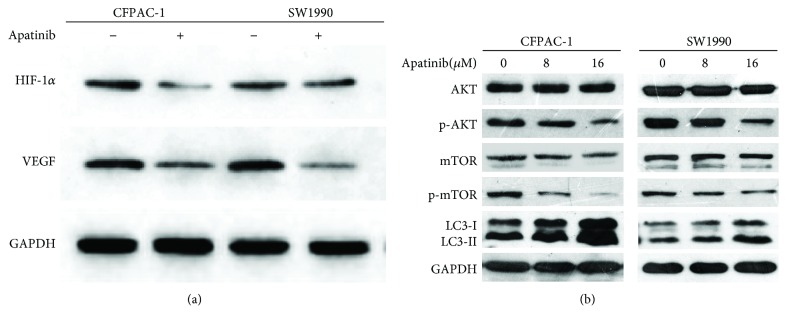
Apatinib inhibited the expression of HIF-1α and the AKT/mTOR pathway. (a) CFPAC-1 and SW1990 cells were treated with apatinib (0 or 16 μM) for 24 h, and alterations in the expression of HIF-1α and VEGF were determined through western blotting. GAPDH was included as a loading control. (b) CFPAC-1 and SW1990 cells were treated with different concentrations of apatinib (0, 8, and 16 μM) for 24 h, and the levels of phosphorylated AKT, mTOR, and LC3 were determined through western blotting. GAPDH was used as a loading control. All experiments were performed in triplicate.